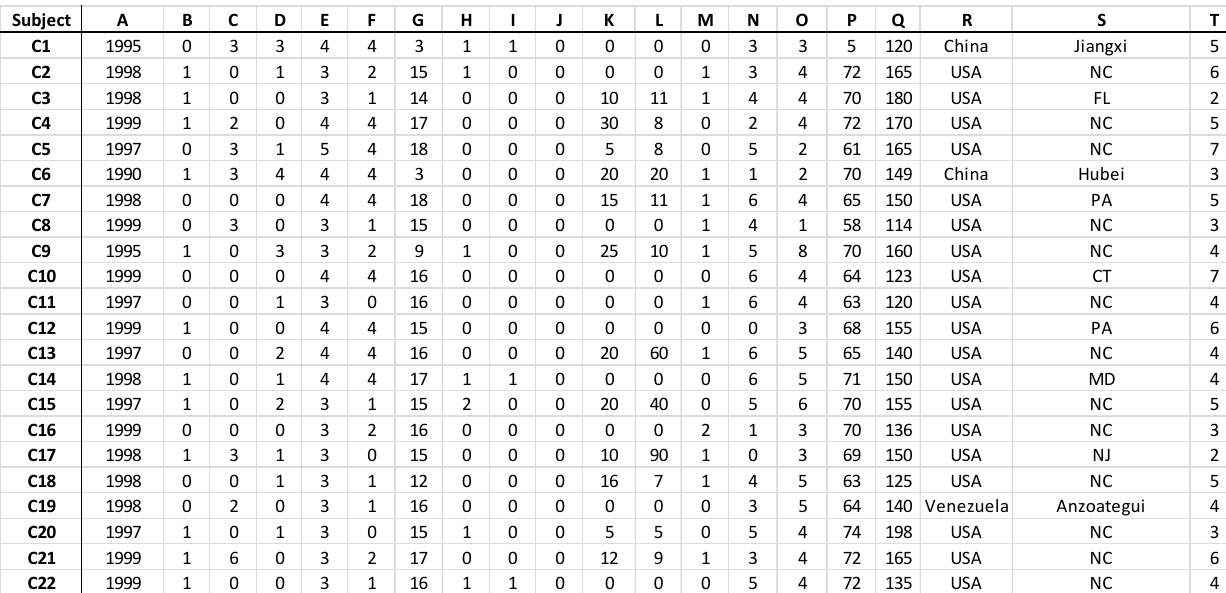
Figure A15. Individual Demographic Data—Session C.